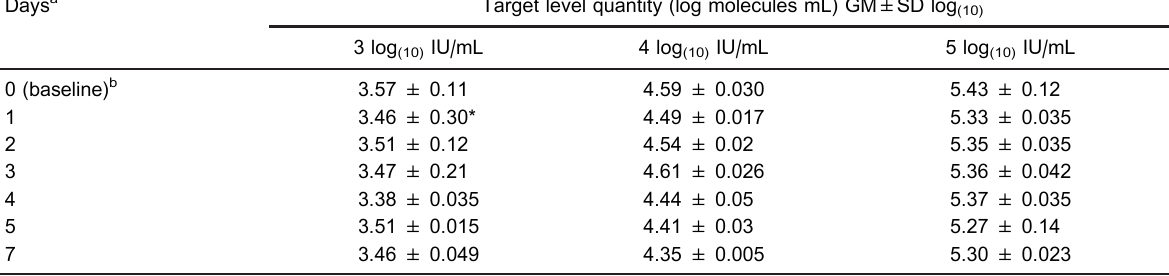
Table 1. Mean values for quantity of triplicates of HBV-positive samples as determined by quantitative polymerase chain reaction before (baseline) and after incubation at 42 6 C. Days